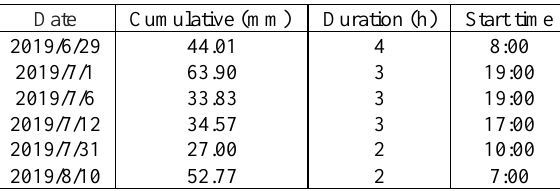
Table 1 . 6 rainfall events information